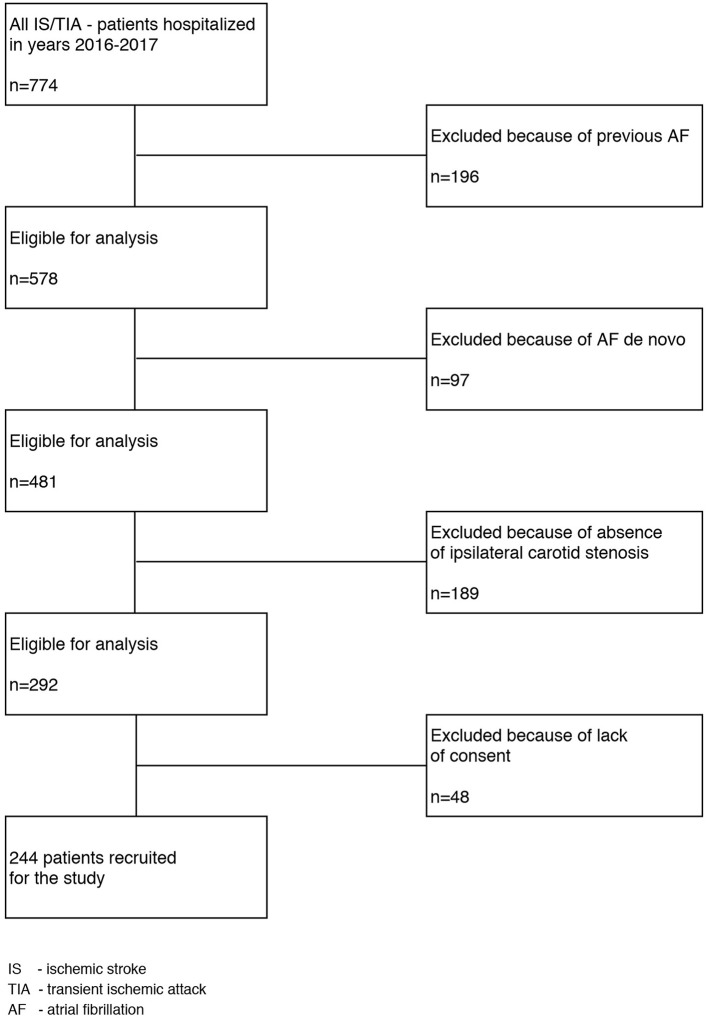
The flow chart of the patients' selection process. Is, ischemic stroke; TIA, Transient ischemic attack; AF, Arial fibrillation.